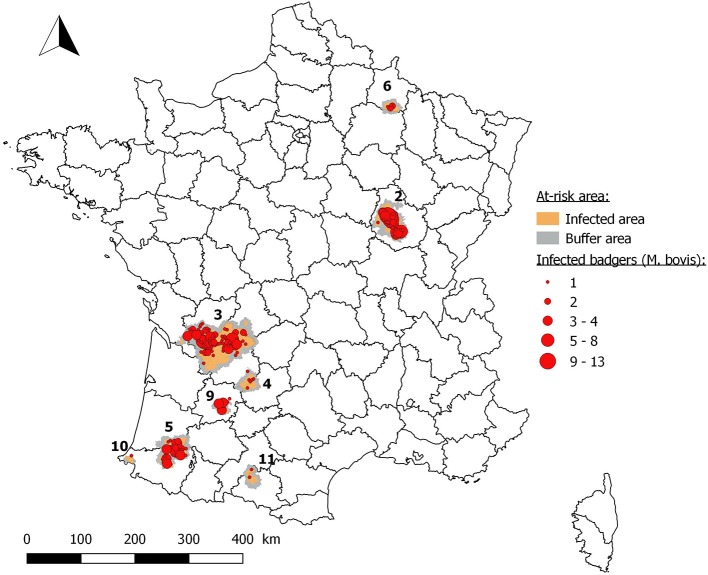
Location of infected badgers collected by targeted surveillance from 2012 to 2017 (2: Côte-d'Or; 3: Dordogne/Charente/Charente-Maritime/Haute-Vienne/Corrèze/Gironde; 4: Dordogne/Lot; 5: Béarn; 6: Ardennes/Marne; 9: Lot-et-Garonne; 10: Pays Basque; 11: Ariège/Haute-Garonne).